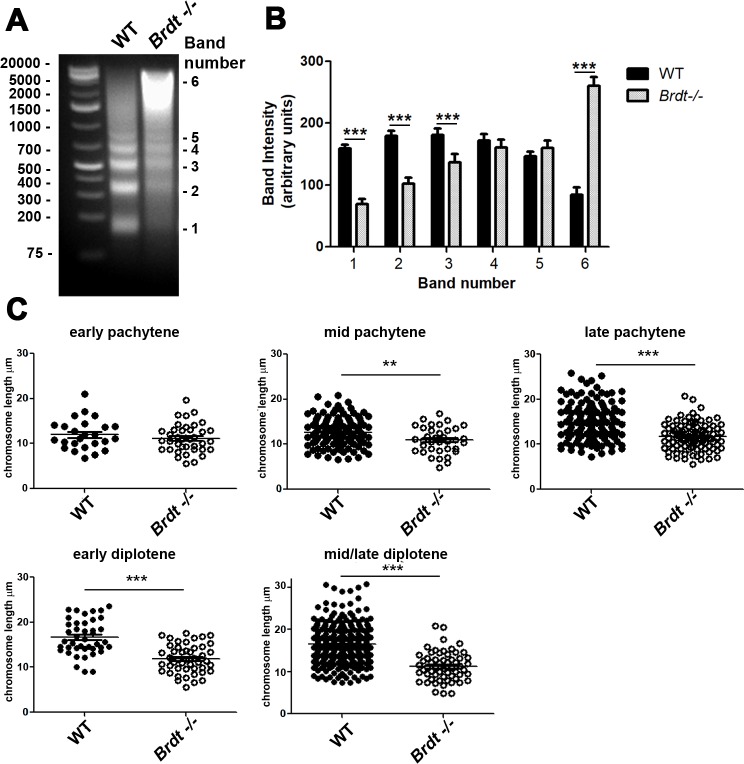
Absence of BRDT leads to a global chromatin condensation and a decrease in the length of the SC of autosomal chromosomes.Chromatin from seminiferous tubules from 17 day old WT and Brdt-/- testes was digested with 1U/ul MNase. In WT chromatin, MNase digestion produced low molecular weight bands corresponding mainly to mono- (band 1), di- (band 2) and tri- (band 3) nucleosomes. MNase digestion of Brdt-/- chromatin leads to digestion products with the bulk of chromatin ranging between 1500 and 4000 kb in size (bands 4 and 5) and a concomitant reduction in the mono-, di- and tri nucleosome fractions. Four WT and Brdt-/- mice were used per experiment; 3 experiments total. (B) Quantification of the intensity of the bands obtained after digestion with MNase of WT (black bars) and Brdt-/- (grey bars) chromatin. Error bars indicate standard deviation. *** p<0.001. (C) The length of each SC from autosome chromosomes in WT (black circles) and Brdt-/- (white circles) spermatocytes was measured and quantified in micrometers. **p<0.0028, ***p<0.0001. Error bars indicate standard deviation. Samples were obtained from three WT and Brdt-/- mice. n = 22 and 39 early pachytene; 92 and 45 mid pachytene, 147 and 105 late pachytene; 38 and 53 early diplotene, and 158 and 65 mid/late diplotene WT and Brdt-/- spermatocytes, respectively.